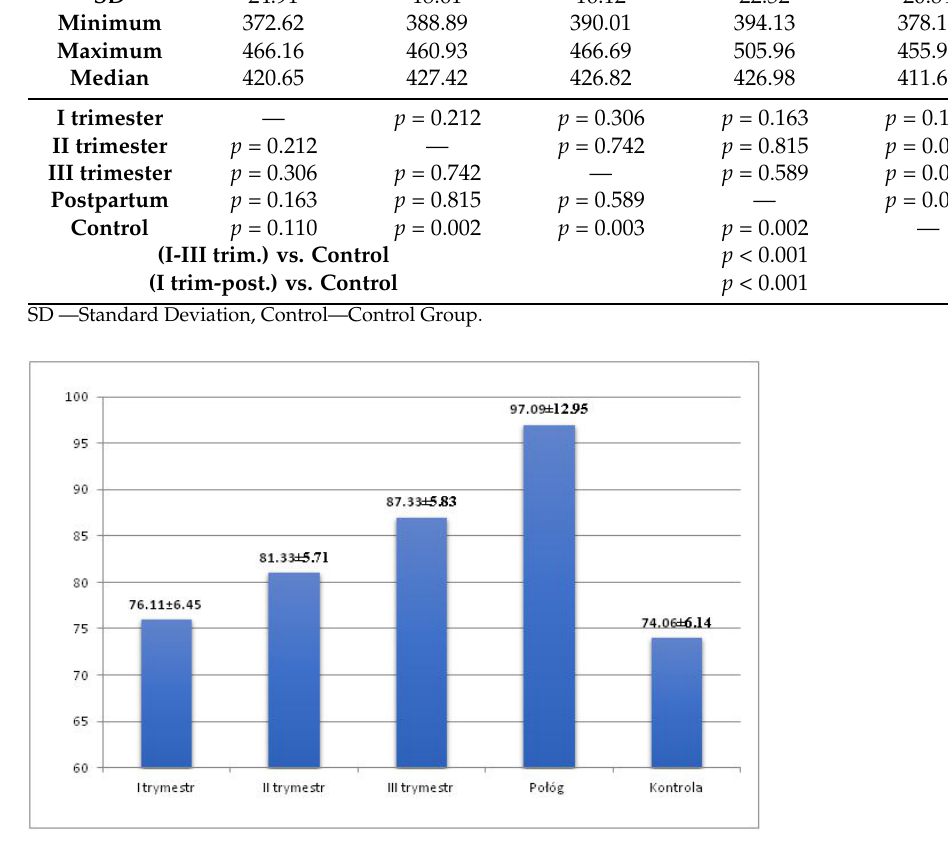
Figure 3. TpTe interval in the 1st, 2nd, and 3rd trimester of pregnancy, in the puerperium and in the control